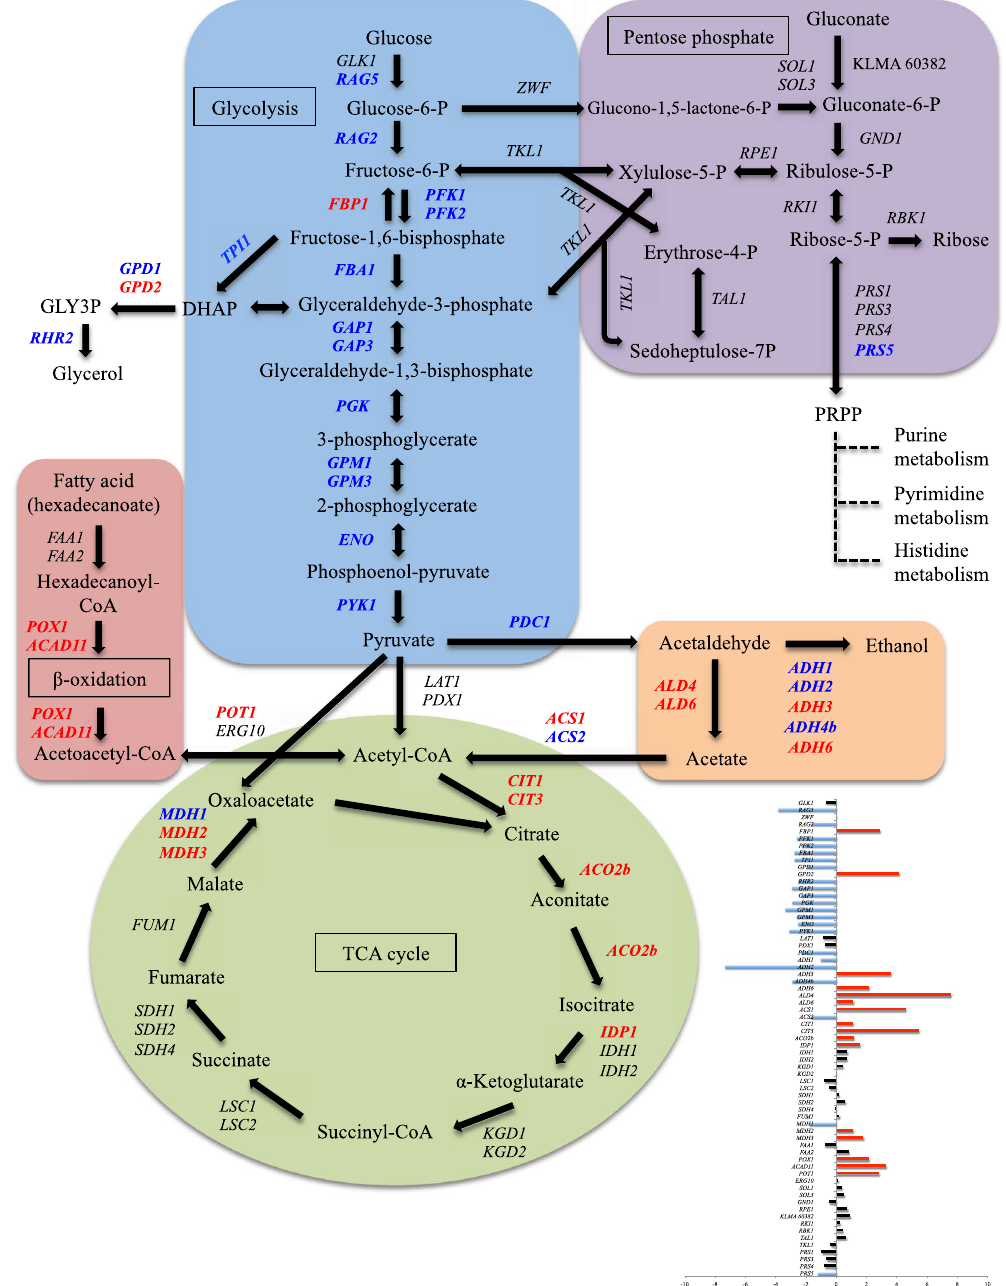
Figure 4. Expressional change of genes for the central carbon metabolic network in Kmmig1 . The ratio of the transcriptional level of each gene in Kmmig1 to that in the parental strain that is presented by log 2 (fold change) is shown at the right bottom side. Red-coloured bars: significantly up-regulated genes in Kmmig1 ; blue-coloured bars: significantly down-regulated genes; black-coloured bars: not significantly changed genes. In the central carbon metabolic network, significantly up-regulated and down-regulated genes in Kmmig1 are represented in red and blue, respectively, and genes that were not significantly changed in Kmmig1 are represented in black. Further details are given in Supplementary Information File